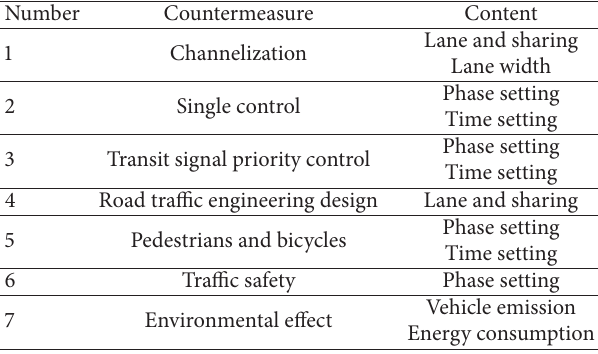
Table 1: Automation countermeasure for intersection optimization.